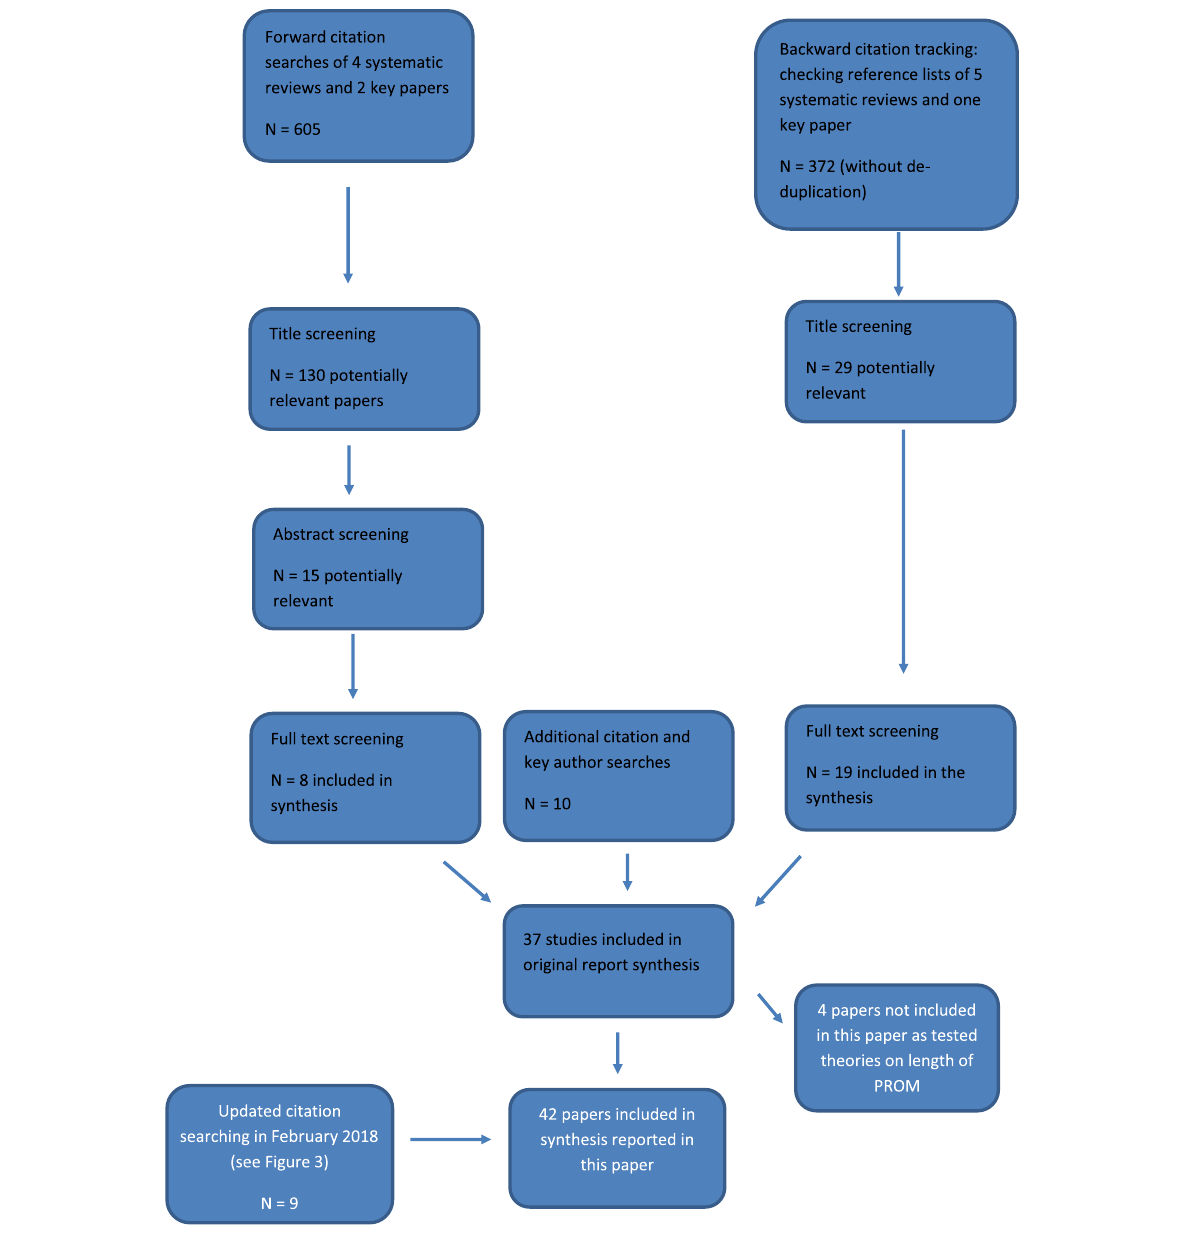
Fig. 2 Process of paper review and selection for synthesis reported in this